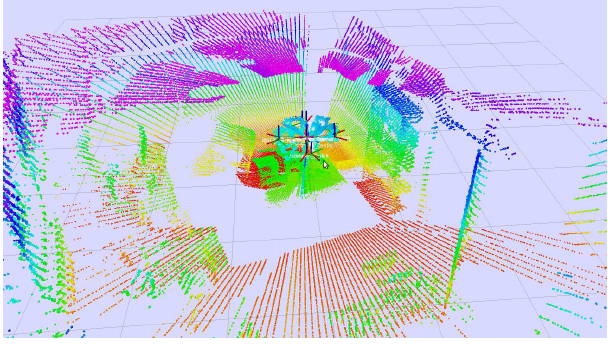
Figure 3: A 3D scan of an indoor environment acquired with our continuously rotating laser